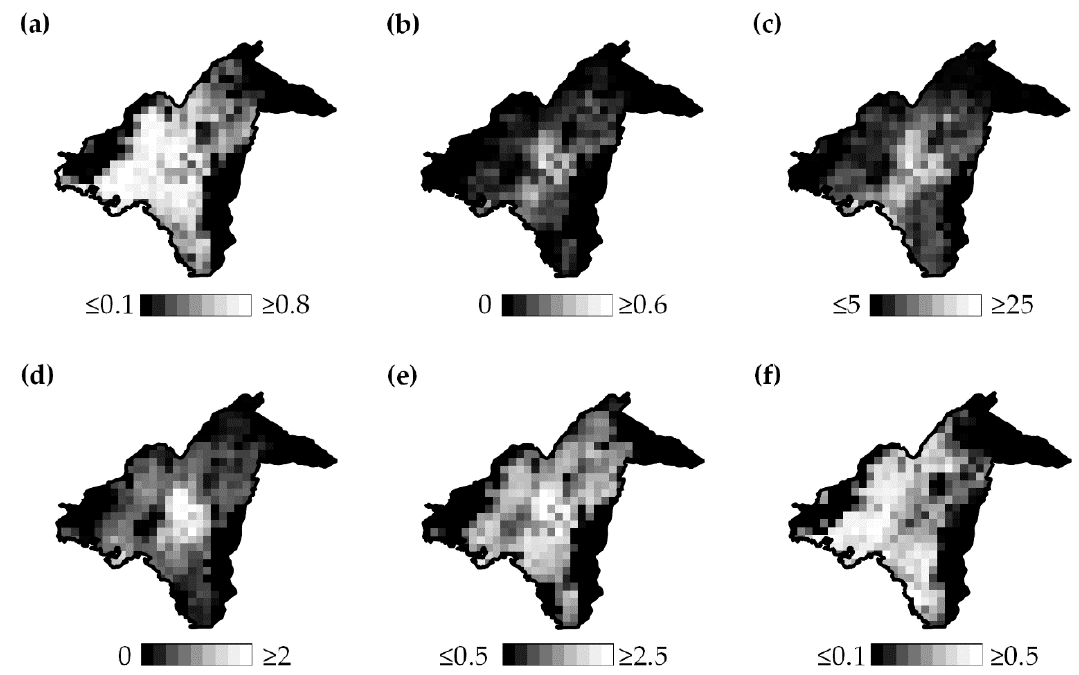
Figure 3. Spatial distribution of the surface parameters in Athens at 1 km resolution: ( a ) λ imp , ( b ) λ b , ( c ) H , ( d ) H / W , ( e ) λ c , and ( f ) λ i .